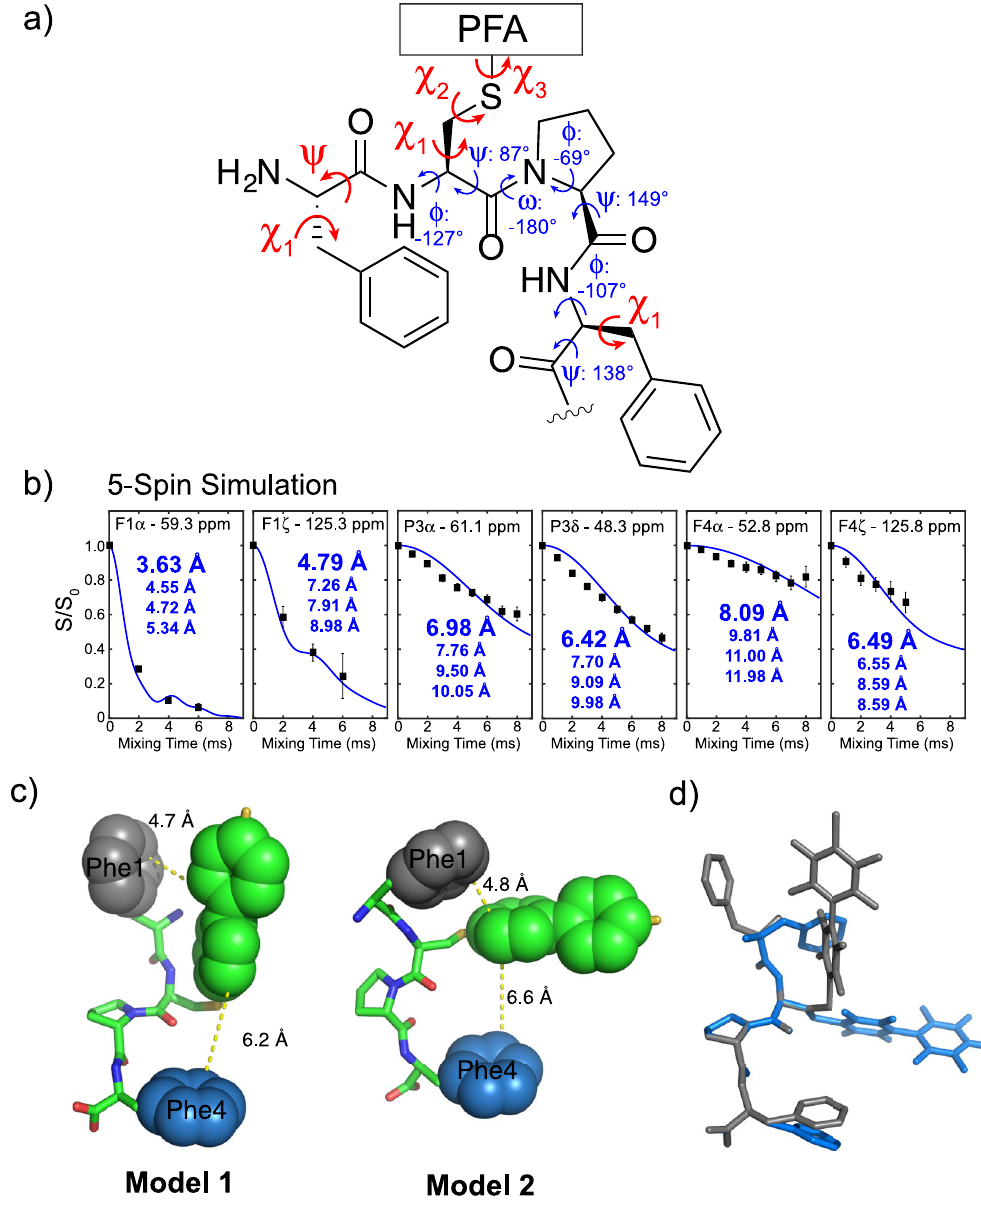
Figure 6. Two structural models for PFA-tagged π -clamp show similar backbone structures but distinct Phe1- PFA interaction. ( a ) The average predicted backbone torsion angles (shown in blue) and the torsion angles varied for fitting (shown in red). ( b ) Representative model-dependent, best-fit 5-spin SIMPSON simulations of the experimental REDOR curves for the resolved 13 C sites. For each simulation of torsion angle combinations, the four nearest 19 F atoms to a 13 C site were included in the simulation. ( c ) Structural model of the PFA-tagged π -clamp motif based on the predicted backbone torsion angles and REDOR distance restraints. Model 1 (left) uses Phe1 C α and C β for fitting, giving torsion angles of Phe1 ψ = 90° and χ 1 = − 60°, Cys2 χ 1 = 60°, χ 2 = − 60°, and χ 3 = − 30°, and Phe4 χ 1 = − 90°. Model 2 (right) uses Phe1 C α ’ and C β ’ for fitting, giving torsion angles of Phe1 ψ = − 60° and χ 1 = 150°, Cys2 χ 1 = − 120°, χ 2 = 180°, and χ 3 = 180°, and Phe4 χ 1 = − 120°. The shortest carbon-to-carbon distance between Phe side chains and PFA were shown. ( d ) Superimposition of the two models around